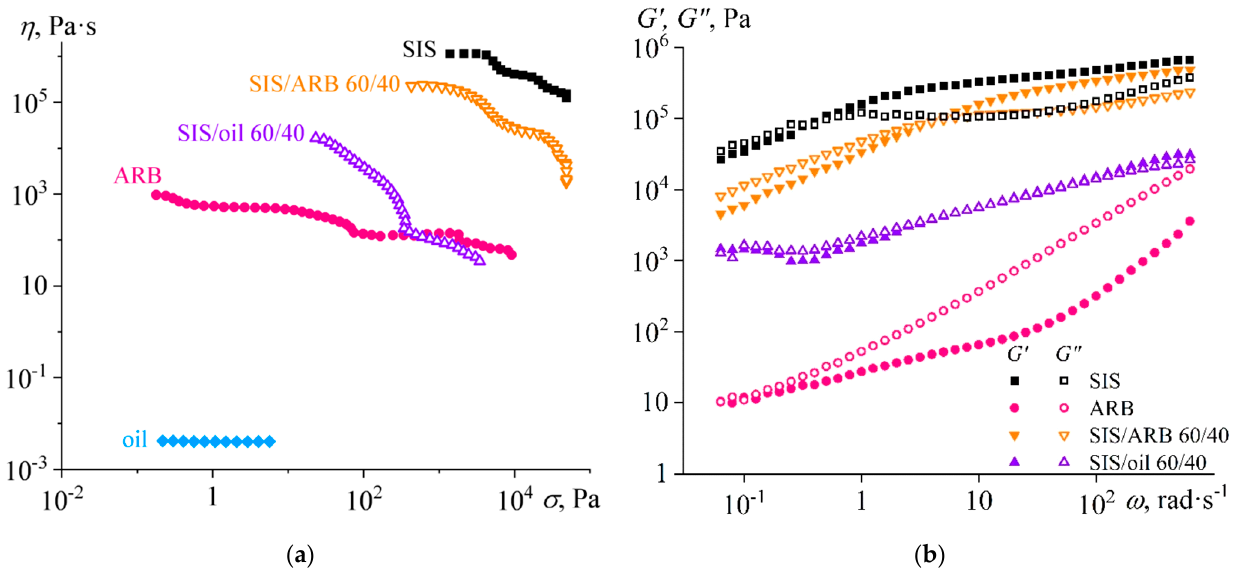
Figure 1. Flow curves ( a ) and frequency dependences ( b ) of storage (filled symbols) and loss (hollow symbols) moduli for styrene ‐ isoprene ‐ styrene triblock copolymer (SIS), asphaltene/resin blend (ARB), naphthenic oil, and their binary mixtures at 120 °C. Figure 1b shows no data for the oil because it does not exhibit viscoelasticity.